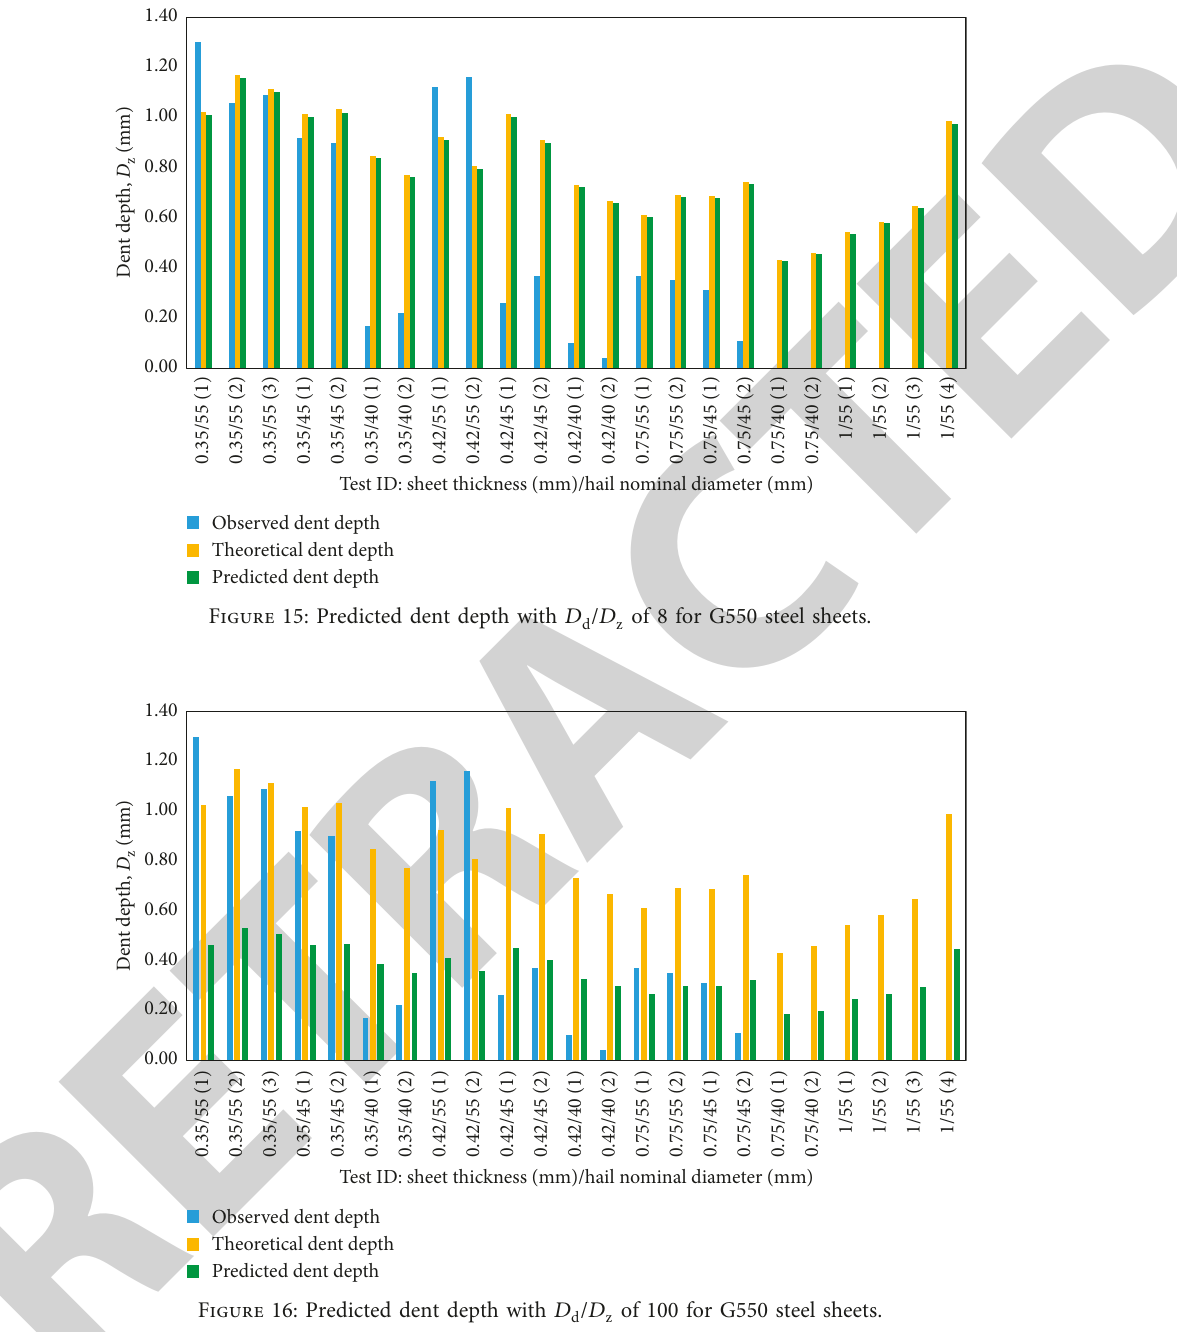
D d / z of 100 for G550 steel